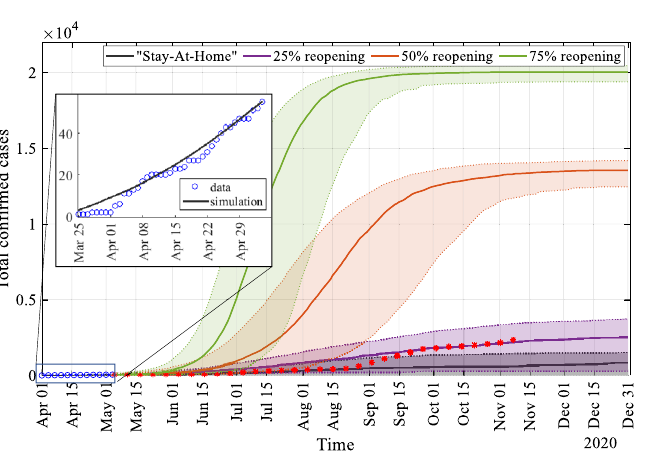
Figure 4. Total confirmed cases with time in the four reopening scenarios after ‘stay at home’ order lifted on May 4, 2020. Solid lines represent the median, and shaded regions represent interquartile range of the 1000 stochastic realizations. The blue circles in the zoom-in window present the total confirmed case data of the COVID-19 in Manhattan (Kansas) for the time period from March 25, 2020 to May 4, 2020. We have used this time period to estimate the basic reproductive number and the average confirmed time. The red stars are the total confirmed case data of the COVID-19 in Manhattan (Kansas) after May 5,